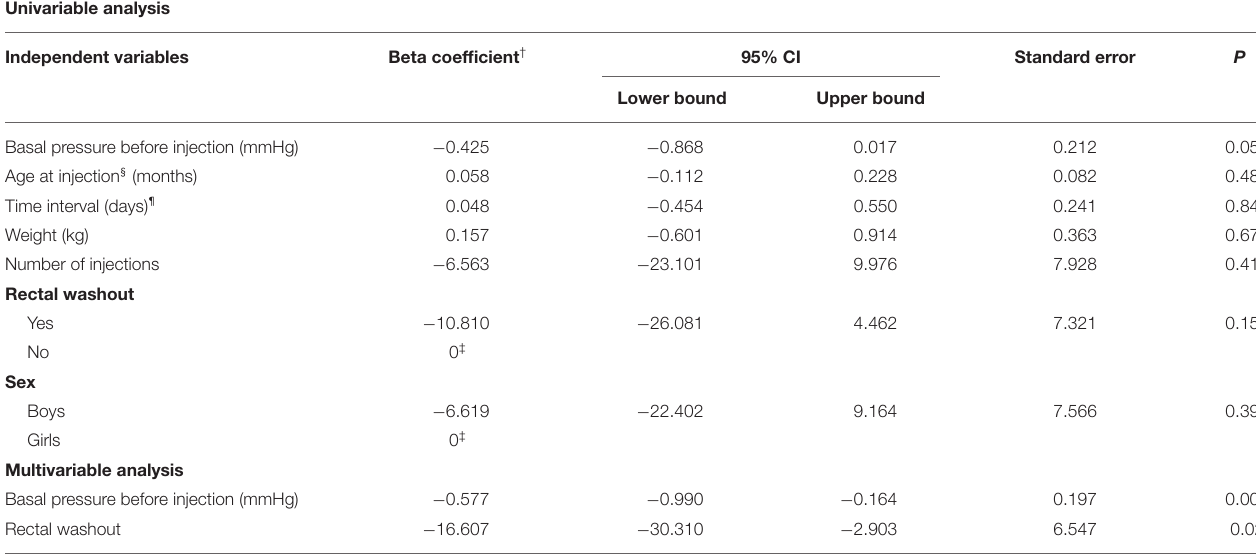
TABLE 4 | Univariable linear regression analyses of factors which possibly influence changes in the anal basal pressure change in cases with organic disorders ( n = 22). Univariable